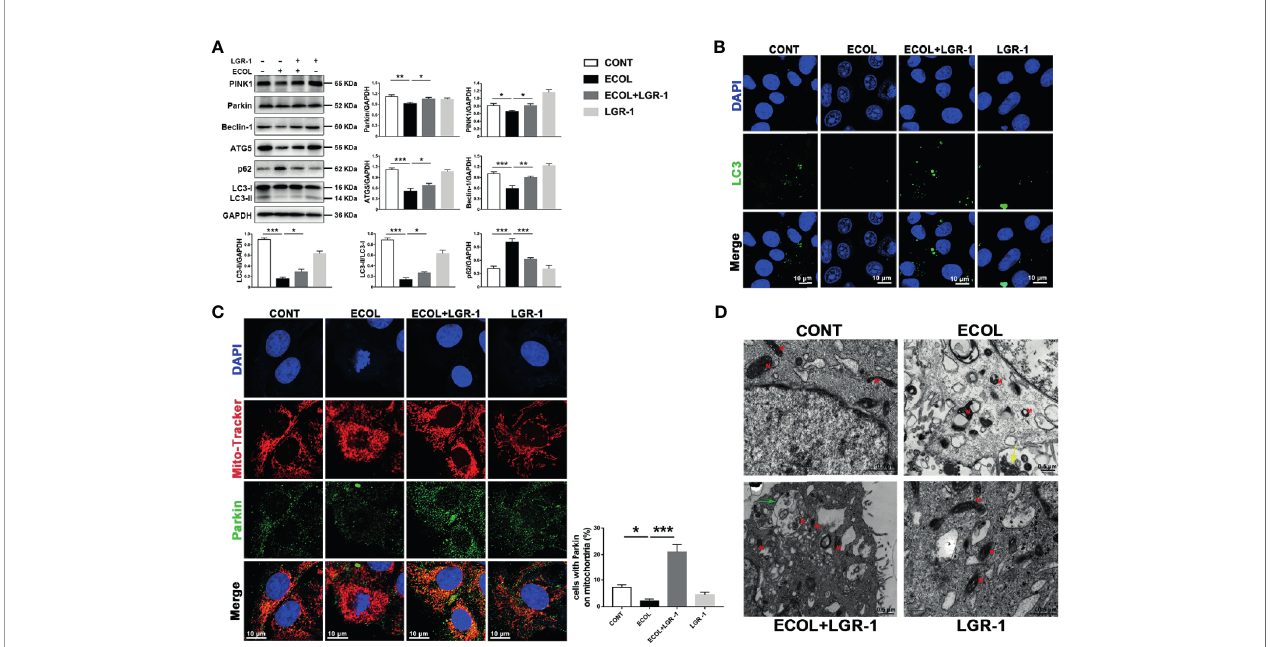
FIGURE 1 | LGR-1 alleviates Escherichia coli -induced inhibition of mitophagy in MAC-T cells. (A) Western blot analysis of PINK1, Parkin, Beclin-1, ATG5, p62, and LC3. The lower right panel shows the protein quanti fi cation using ImageJ software (version 1.50). (B) Representative immuno fl uorescence images of LC3 (green). DAPI (Blue) stains the nucleus. Scale bar, 10 µm. (C) Representative images and quanti fi cation of immuno fl uorescence double-labelling Parkin (Green) and mitochondrial marker (MitoTracker, red). DAPI (Blue) stains the nucleus. Scale bar, 10 µm. (D) Representative TEM images of mitochondria and autophagosomes. Red M, mitochondria; Green arrows, autophagosome; Yellow arrows, E coli . Scale bar, 0.5 µm. Con fl uent MAC-T cell were pretreated with LGR-1 (10 5 CFU/mL, MOI = 1) for 3 h, washed three times with PBS, and exposed to E coli (10 7 CFU/mL, MOI = 66). Cells were analyzed 8 h after E coli infection. Data presented are mean ± SEM; n = 3. * p < 0.05, ** p < 0.01, *** p <